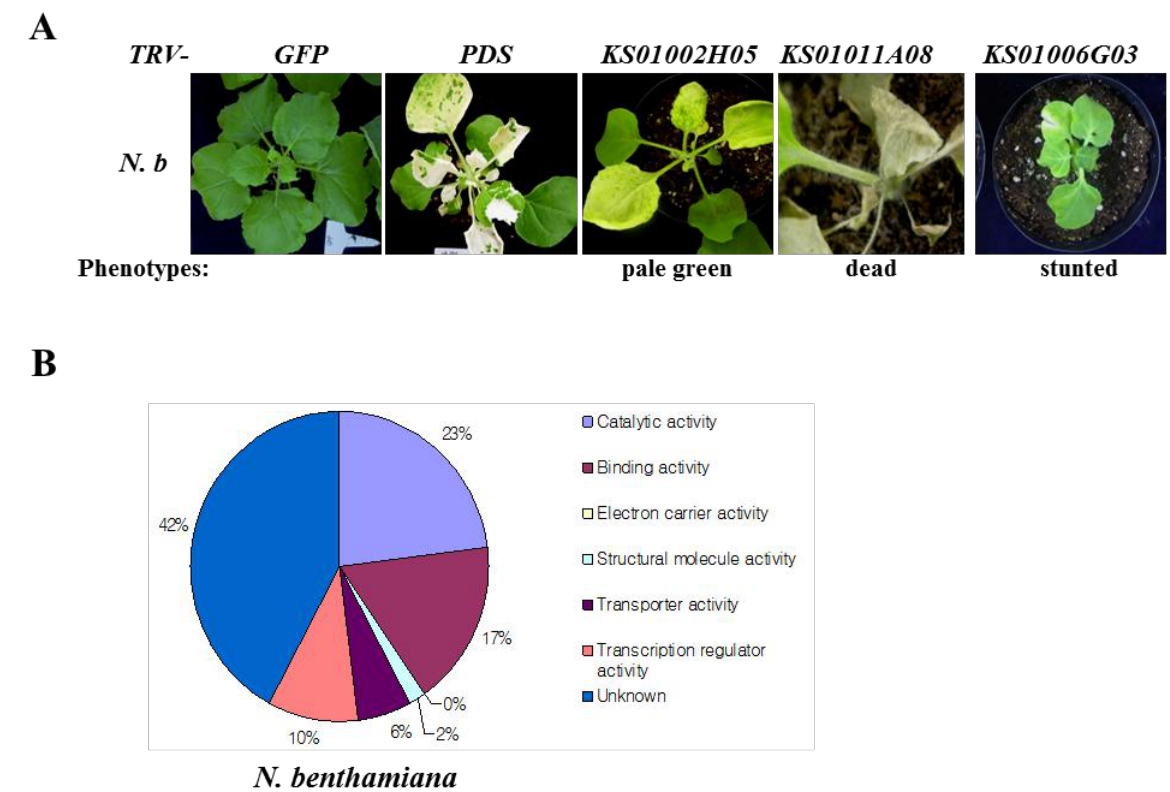
Figure 1. Morphological phenotypes in VIGSed N benthamiana plants. ( A ) Representative morphological phenotypes in N. benthamiana after VIGS. GFP negative and PDS positive controls for the VIGS experiment, respectively; KS01002H05 , KS01011A08 , KS01006G03 , characteristic aberrant phenotypes of the classes pale green, dead, and stunted, respectively. Images of the silenced plants were taken 21 days post-infiltration, respectively; and ( B ) Molecular characterization of pepper ESTs exhibiting morphological abnormalities. Percentages were calculated using the total numbers in N. benthamiana